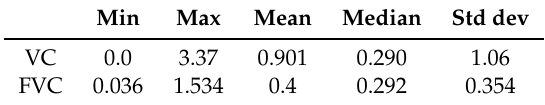
Figure 5. The center positions of the fifty vortexes in the testing group detected by the FVC method (red dots) and the VC method (blue dots). Black lines from inner to outer represent position errors increasing from 0.5 km to 3 km linearly. Table 3. Statistics on position error of two algorithms. Statistics are in